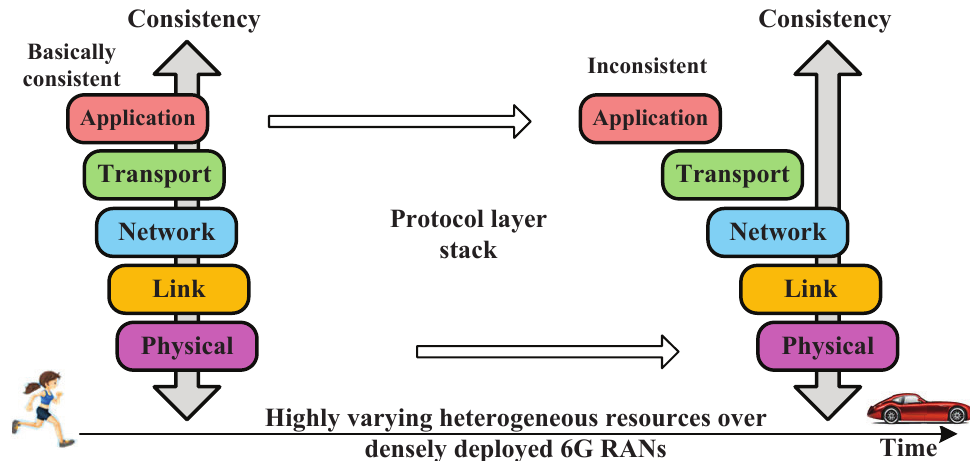
Figure 5. Inconsistent responses to the highly varying heterogeneous network status caused by the loosely coupled protocol